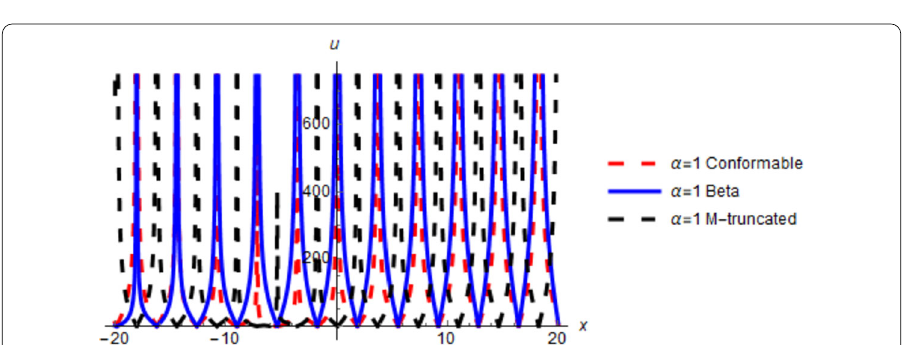
Figure 10 2D-plot with α = 1, β = 0 of u 8 ( x , t ) for different derivatives